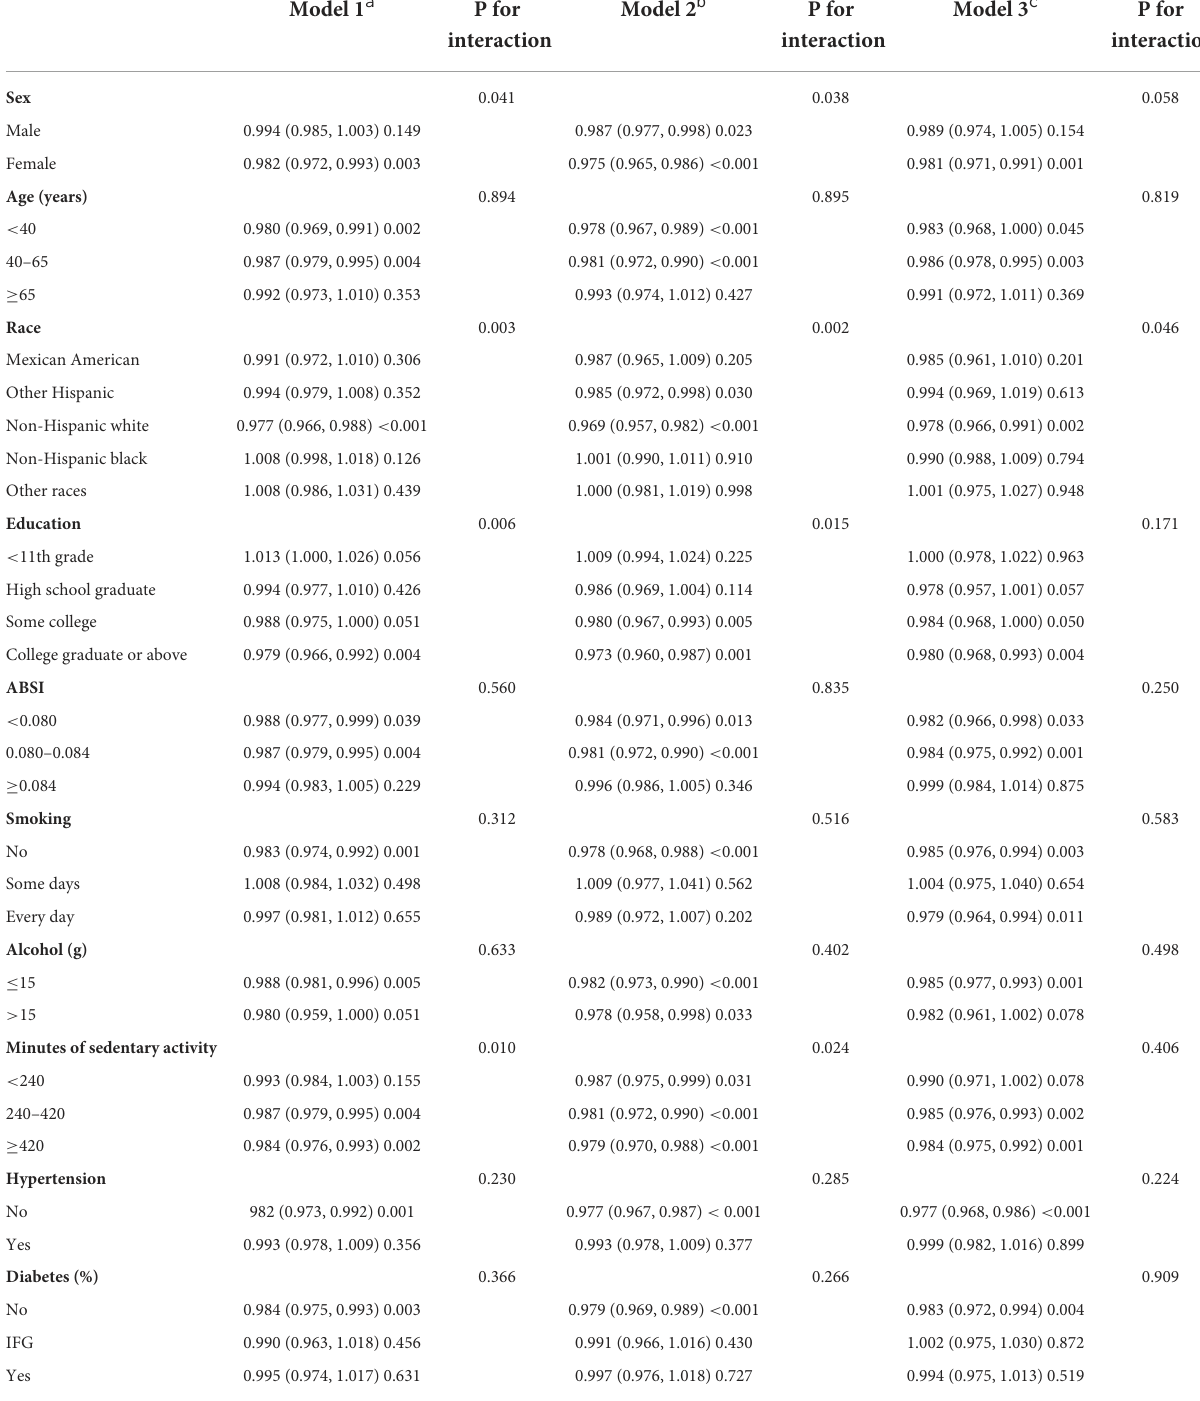
TABLE 4 Stratified logistic regression analysis to identify variables that modify the correlation between HEI-2015 and